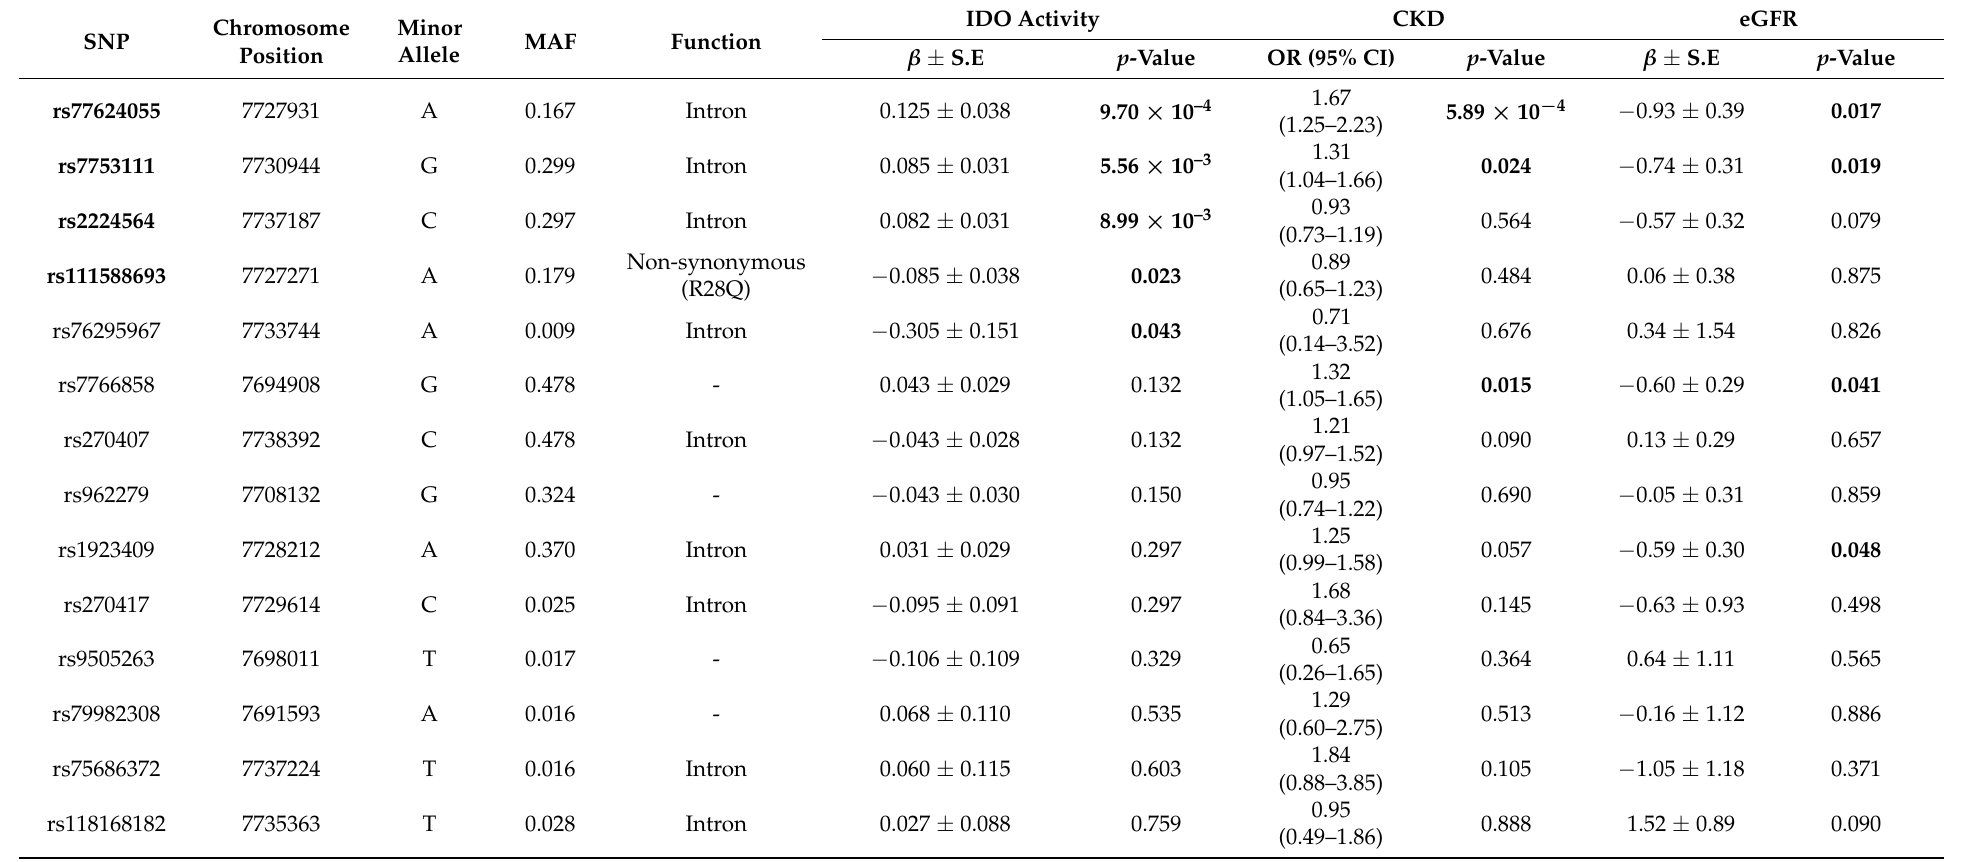
Table 3. Association results of SNPs near BMP6 gene with IDO activity, CKD, and